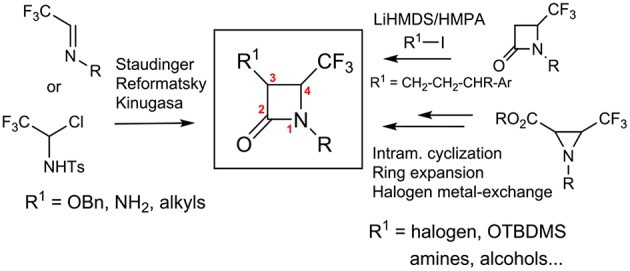
Approaches of C-3 monosubstituted 4-CF3 β-lactams.